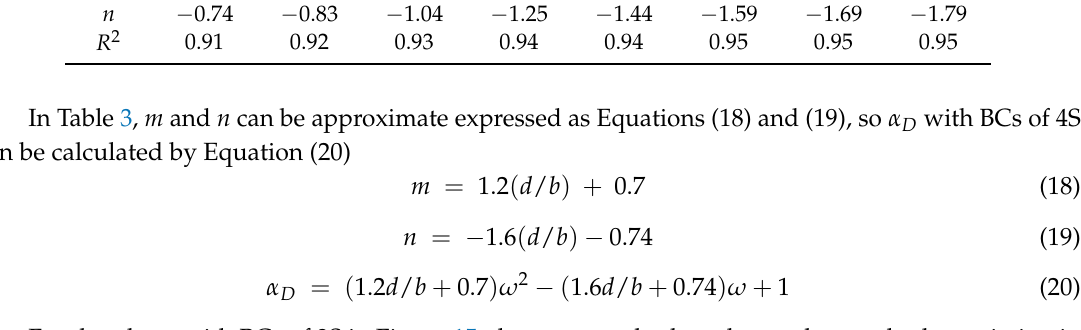
Table 3. The relationship d / b with m and n.